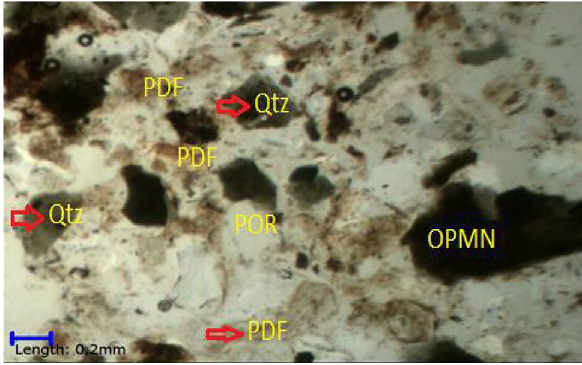
Fig. 9 Quartz grain in Araromi-Obu/Ago-Alaye at depth 81–84 m under crossed polarised light (i.e. nicol). OPMN opaque mineral, PDF partial dissolution of feldspar, POR pore